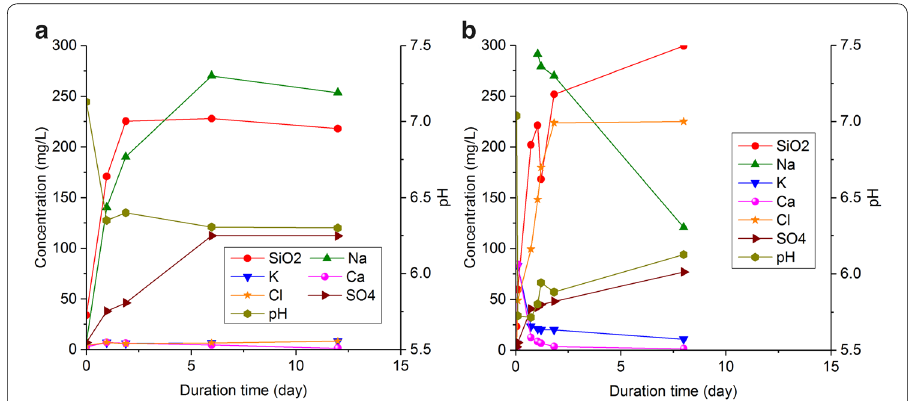
Fig. 10 Change in chemical components over time after injection of a river water, and b water with 3 wt% dissolved CO 2 (Kaieda